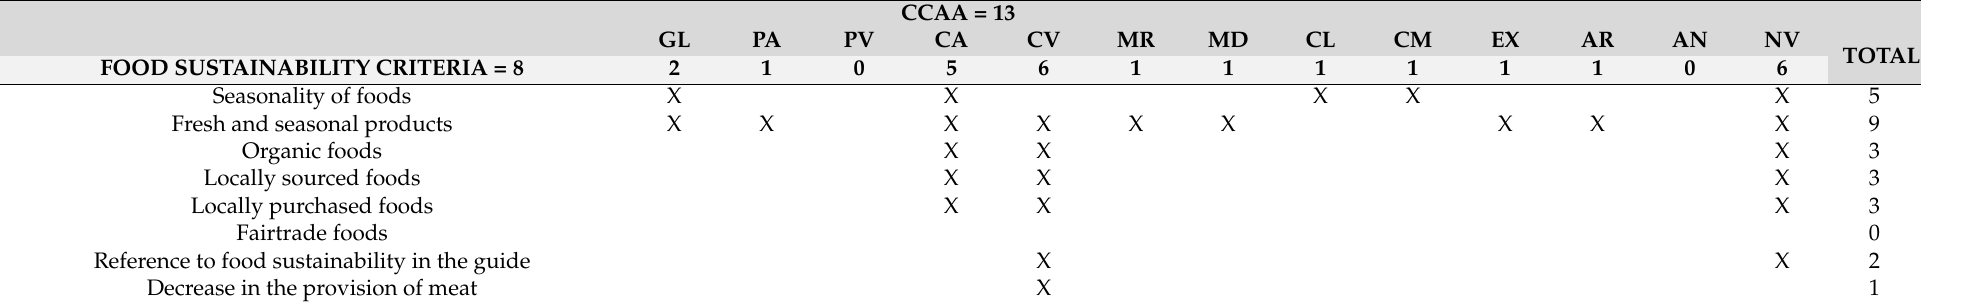
Table 4. Food sustainability criteria included in the food guides for school food services by Autonomous Community